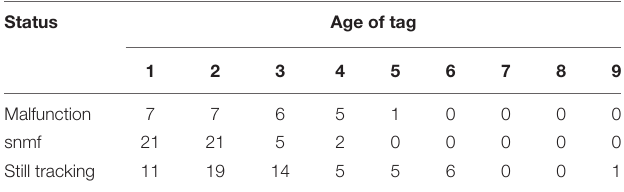
TABLE 2 | Summary of the 136 tags not deemed as settled under the age of first territory settlement (AFTS) algorithm at mid-November 2020 (the study’s analytical cut-off date): according to age and